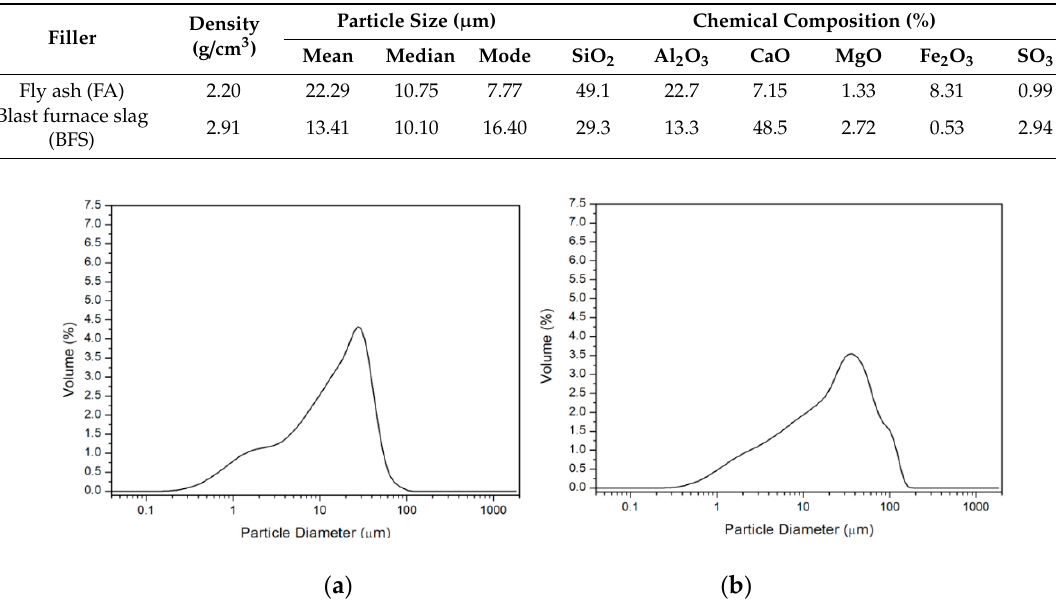
Figure 1. Particle size distribution of fillers from virgin materials: ( a ) Ground calcium carbonate and